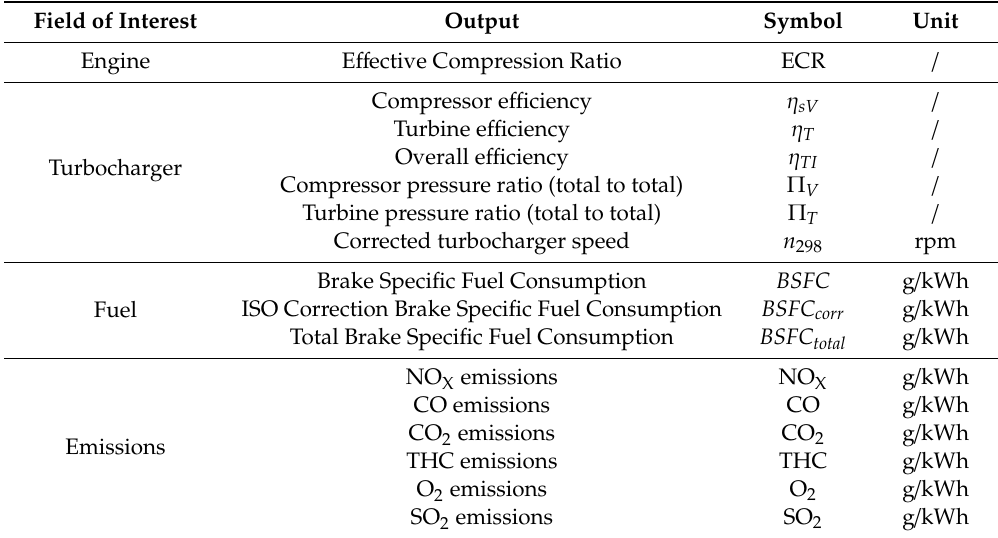
Table 1. Identified